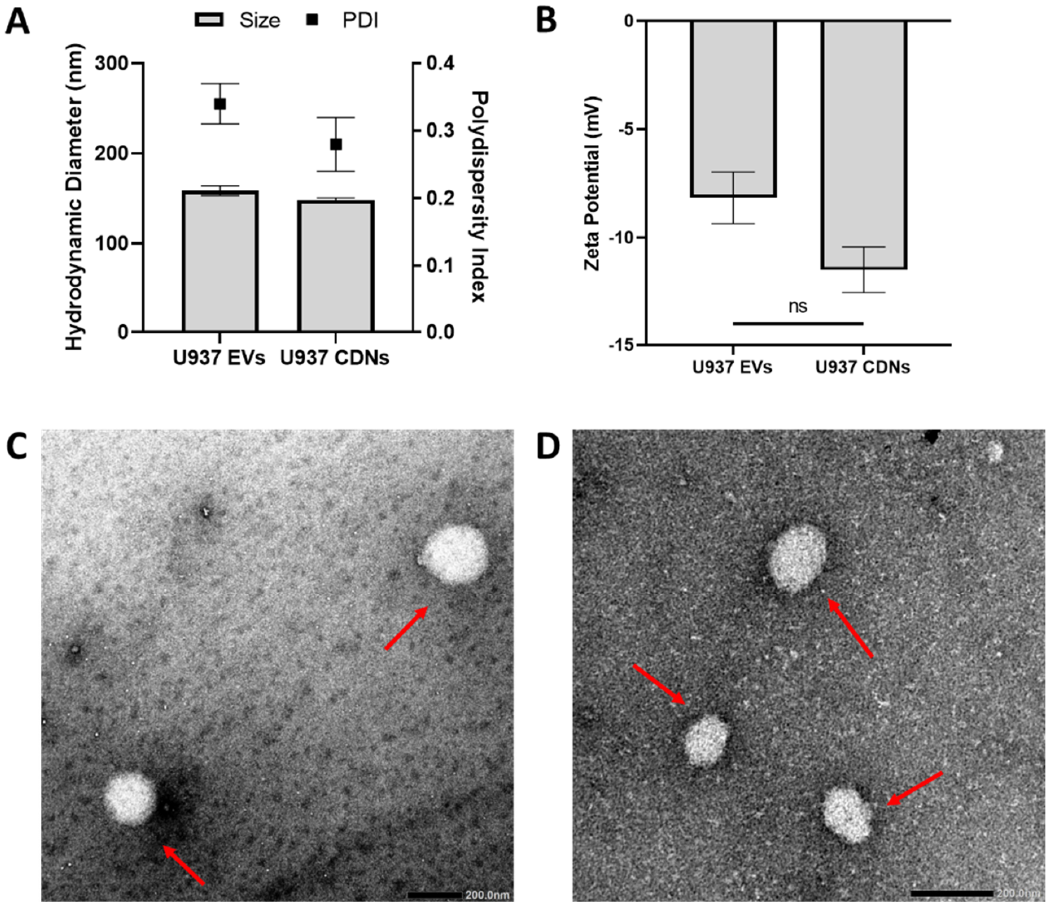
Figure 2. Physical properties of U937 EVs and U937 CDNs. ( A ) Hydrodynamic diameters and polydispersity index of U937 EVs and U937 CDNs; n = 3. Data presented as mean ± SEM. ( B ) Zeta potentials of U937 EVs and U937 CDNs; n = 3. Data presented as mean ± SEM. Transmission electron microscopy images of ( C ) U937 EVs and ( D ) U937 CDNs. The red arrow indicates nanovesicles. The scale bar is 200 nm.